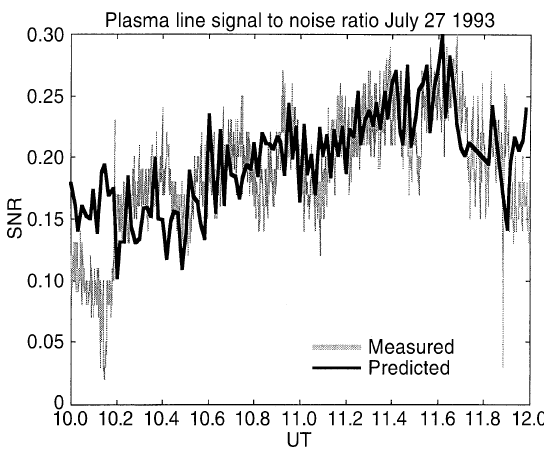
Fig. 5. Comparison between measured and predicted signal-to- noise ratio for plasma line measurements at the peak of the F region on 27 July 1993. The thick gray line denotes mesured SNR , the thin black line is the theoretical value calculated from ion line